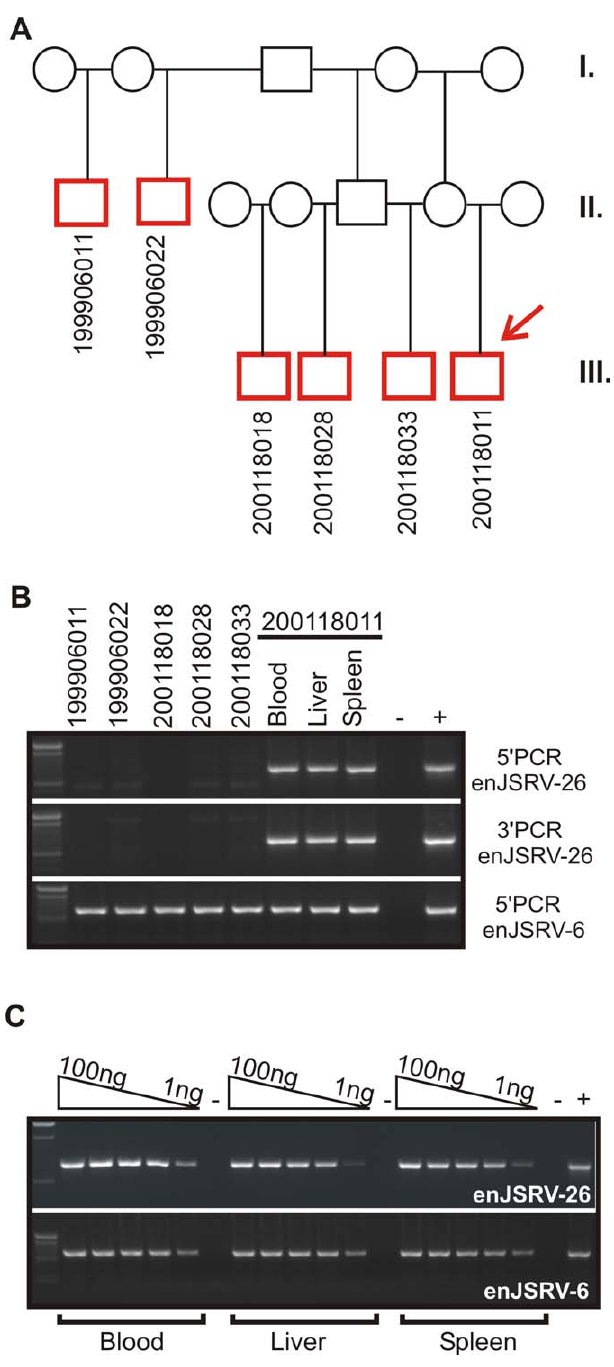
Figure 5. enJSRV-26 Is an Endogenous Retrovirus (A) Genealogical tree illustrating the relationship between ram #200118011 (indicated by an arrow) and its relatives, whose DNA samples were analyzed in this study. The BAC library used in this study was derived from ram #200118011. (B) Detection of enJSRV-26 by amplification of the 5 9 and 3 9 provirus- flanking genomic sequences. enJSRV-26 was detected in blood, liver, and spleen DNA from ram #200118011. Five relatives of ram #200118011 (three half siblings and two sons of the ram grandsire) did not harbor enJSRV-26. The PCR for enJSRV-6 was used as a control for genomic DNA quality. (C) enJSRV-26 was present at relatively the same frequency in blood and tissues of ram